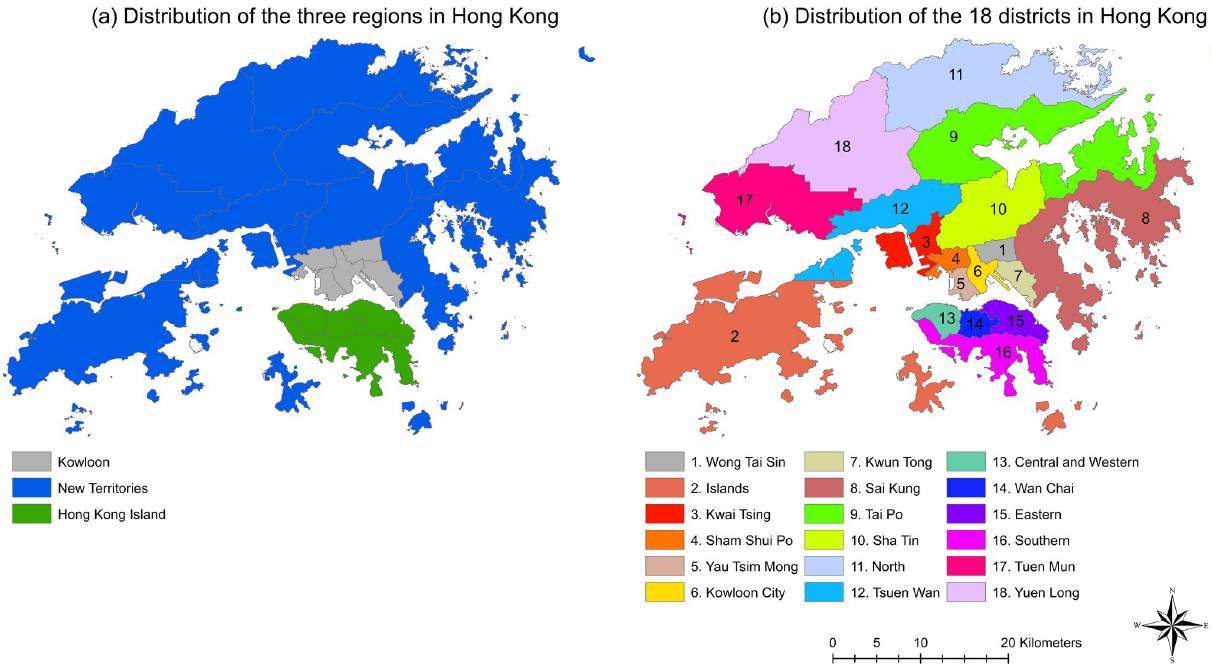
Fig 1. Distribution of the (a) three regions; (b) 18 districts in Hong Kong.